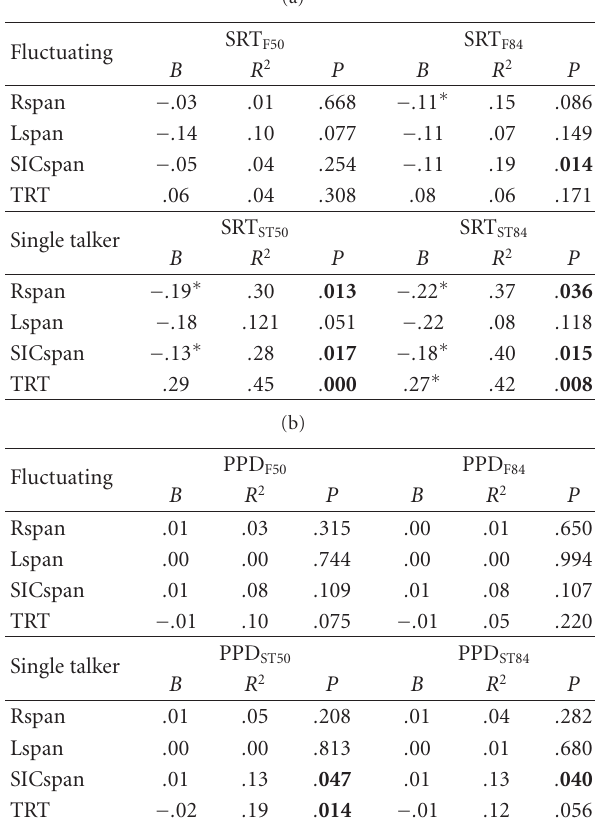
Table 3: (a) Regression models with SRT ST50 , SRT F50 , SRT ST84 and SRT F84 as dependent variables, and both TRT and the cognitive capacity measures as independent variables. (b) Regression models with PPDs in the four conditions as dependent variables, and both TRT and the cognitive capacity measures as independent variables. Shown are the unstandardized regression coe ffi cients ( B ) and the variance ( R 2 ) for all associations. The P values of significant associations ( P < . 05) are presented in bold. In none of the analyses PTA appeared to be a significant confounder. We adjusted for